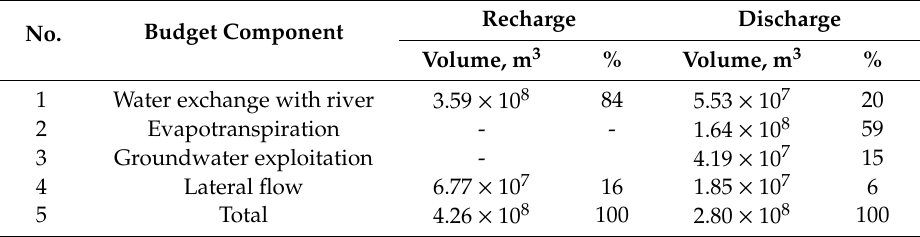
Table 3. Groundwater budget of the model domain from 21 April 2010 to 7 September 2012.